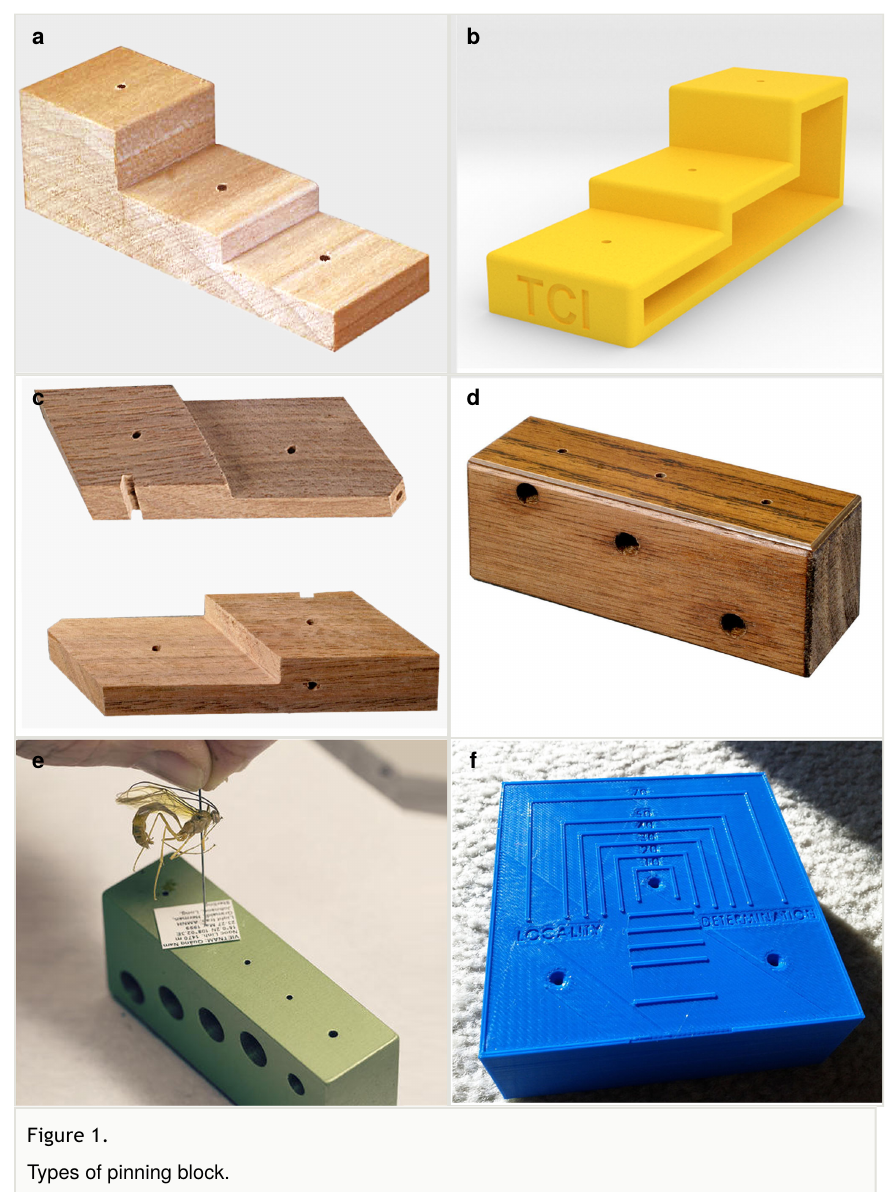
Figure 1. Types of pinning